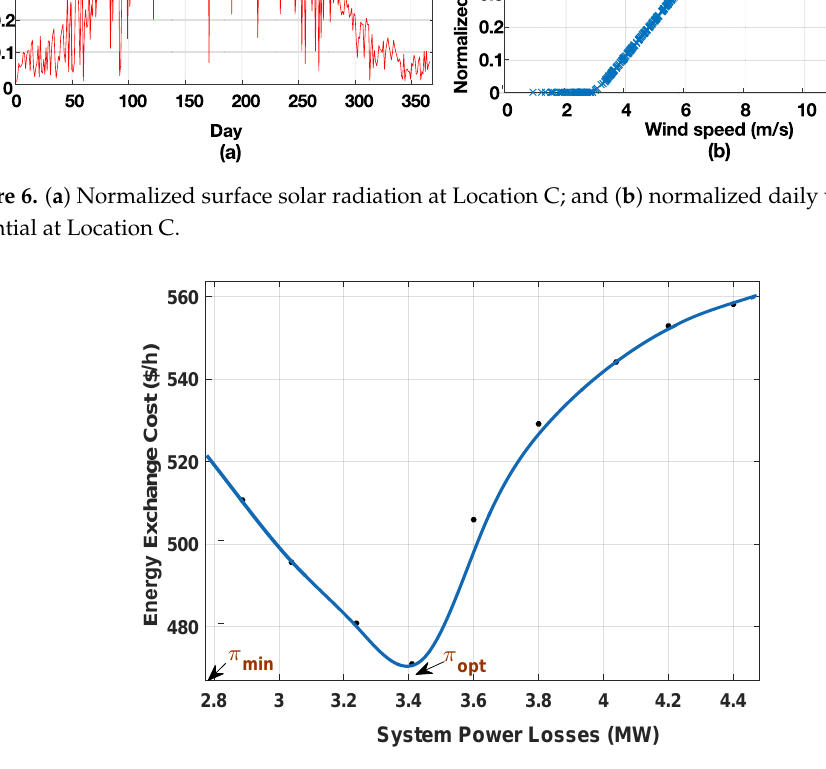
Figure 7. Annual energy exchange cost, C ex , α , against different threshold levels of total SPL, π . Note that these results were plotted for Case-III with the average complementarity value of − 0.66 with equal shares of